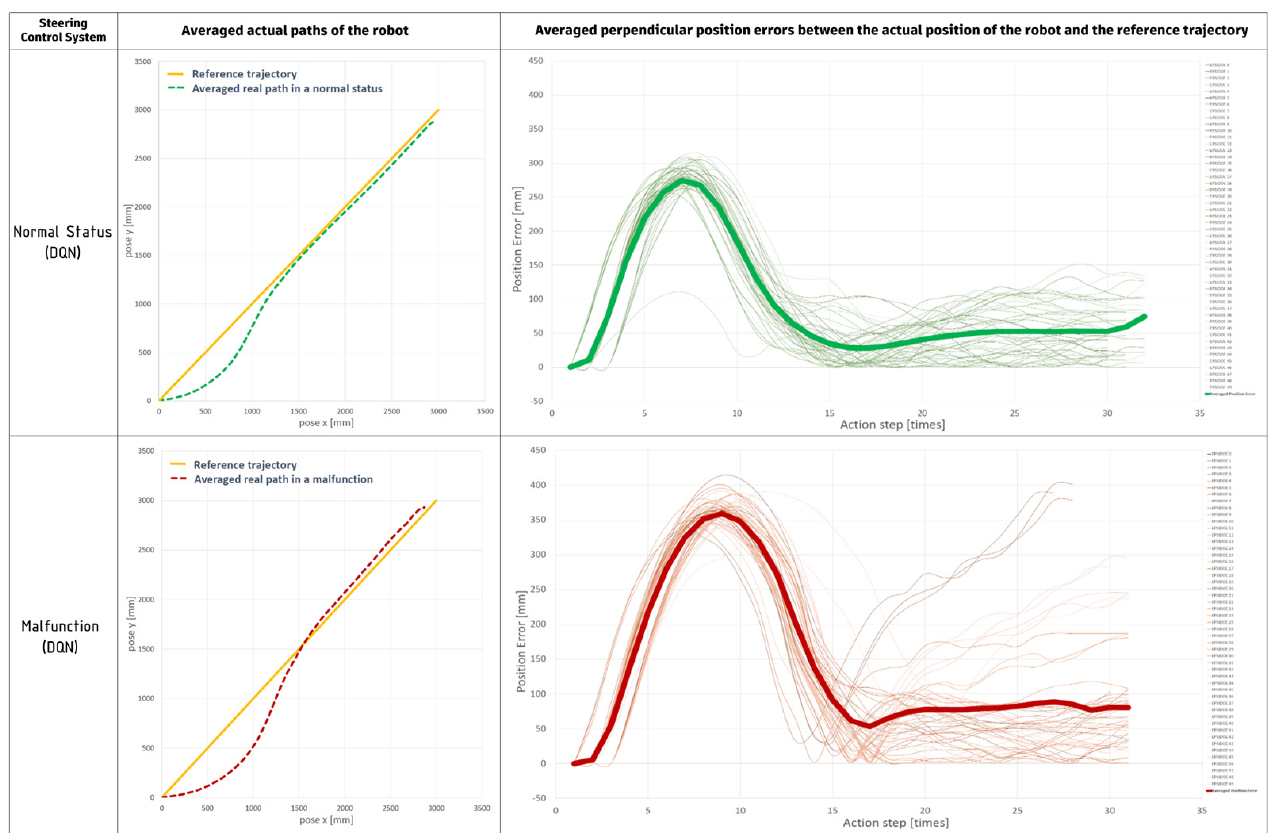
Figure 22. Averaged actual paths and perpendicular position error from the optimum reference tra ‐ jectory obtained through repeated experiments on motion planning with the DQN.